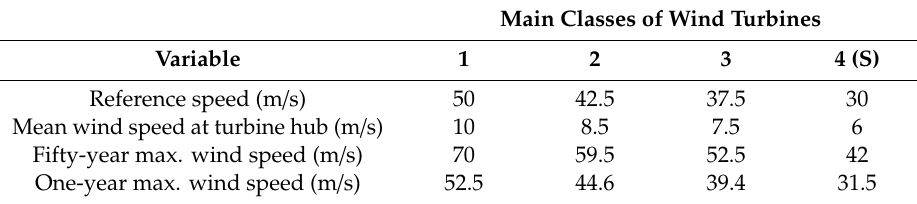
Table 4. International electrotechnical commission wind turbine categories.